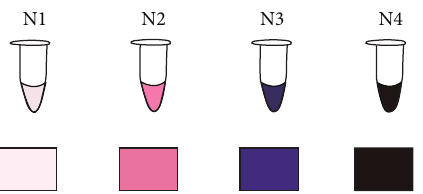
Figure 1: Color scheme of reactive gel intensity color (excess of superoxide anions) after reaction with superoxide anion present in the ejaculate. N1: low OS, N2: low-medium OS, N3: medium-high OS, and N4: high